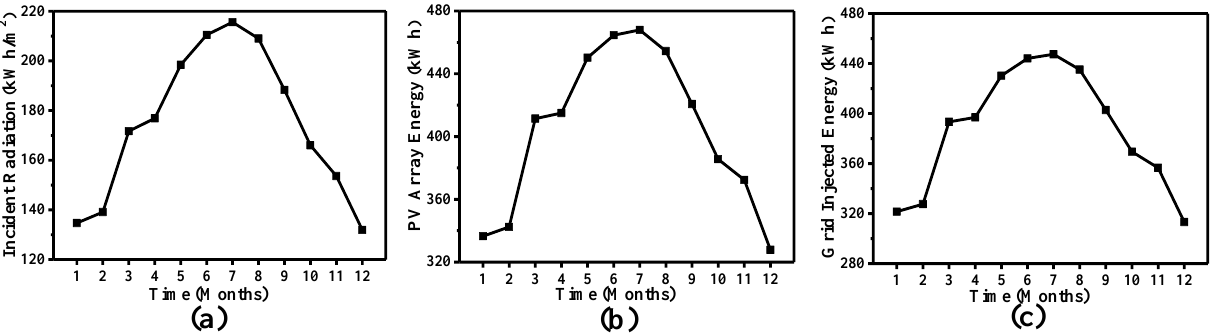
Figure 8: [Seasonal-T(13, 51), A(0)] Configuration: (a) incident radiation received by the module surface, (b) generated energy by the array, and (c) energy injected to the grid.